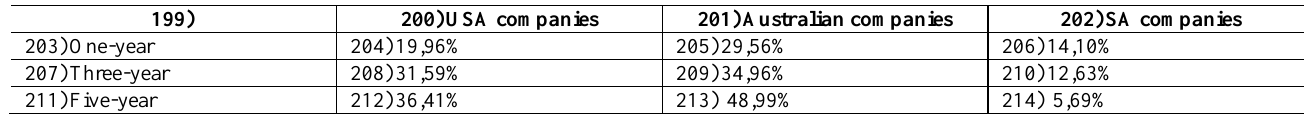
Table 12: Comparison between USA, Australian and SA companies - adjusted R²